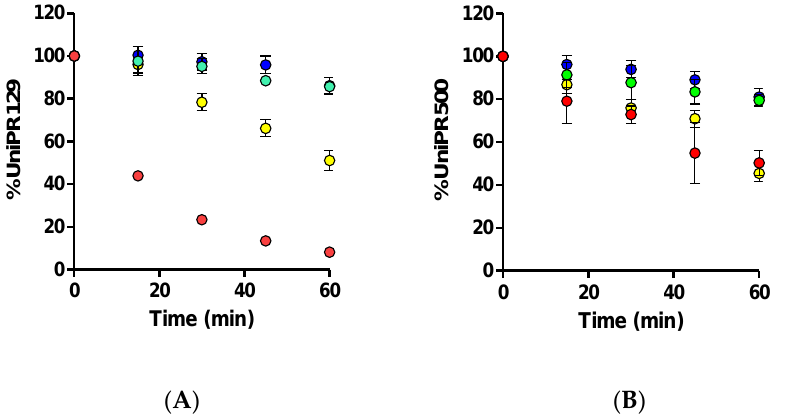
Figure 2. Metabolic stability of ( A ) 1 μM UniPR129 and ( B ) 1 μM UniPR500 to phase I metabolism in MLM (red dots), phase II glucuronidation in MLM (green dots), phase II sulfonation in mouse (blue dots), and human S9 liver fractions (yellow dots).